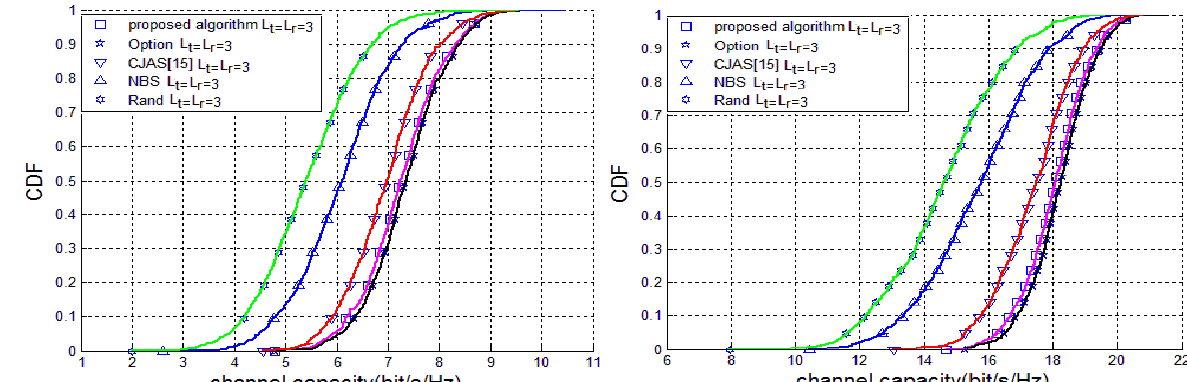
Fig. 9 the curves of capacity CDF for { 5 , 3;5 , 3 } system,